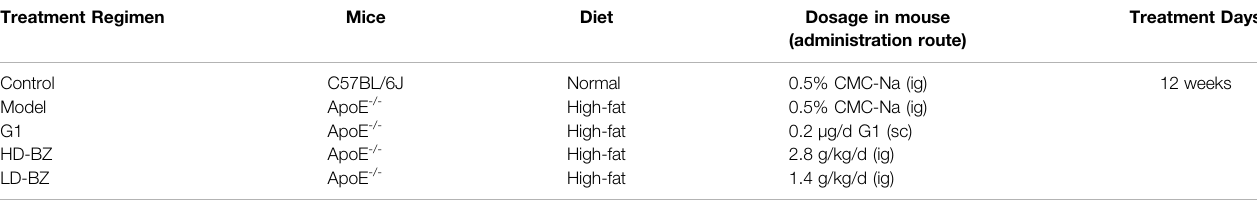
TABLE 2 | Treatment protocol of mice. Treatment Regimen